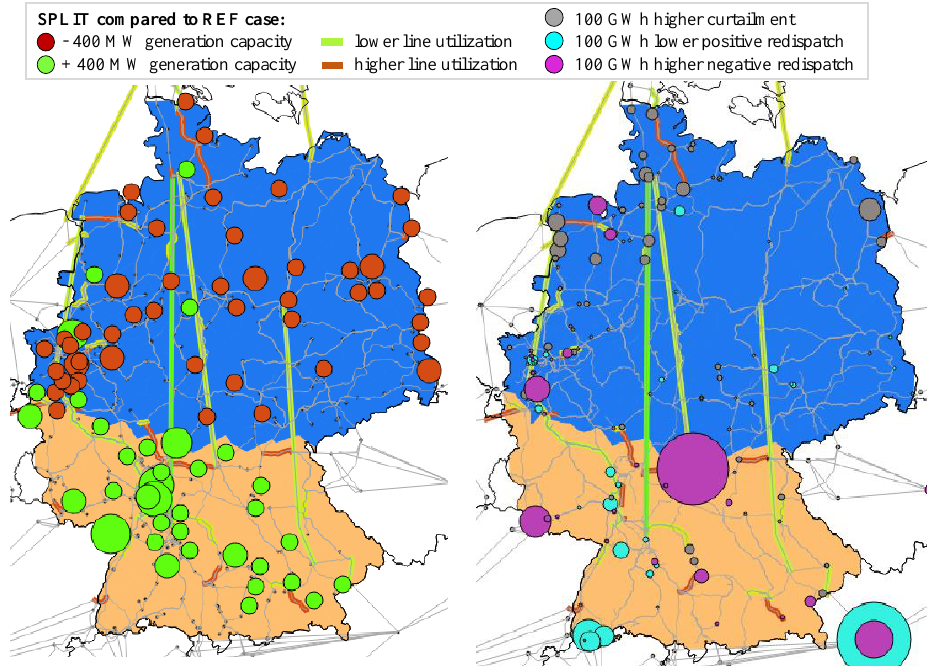
Figure 11. Regional distribution of the new power plant capacities ( left ) and congestion management measures ( right ) in the SPLIT case as compared to the REF